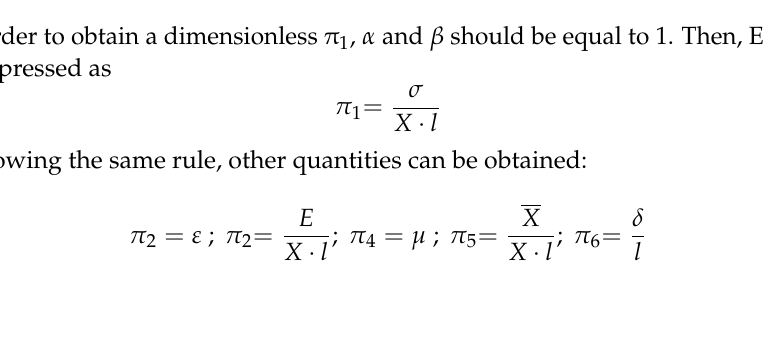
Figure 1. Schematic diagram of the test model: ( a ) schematic diagram of the test model (unit: cm); ( b ) sectional view of the model (unit: cm); ( c ) layout of micro-piles and pressure gauges (unit: